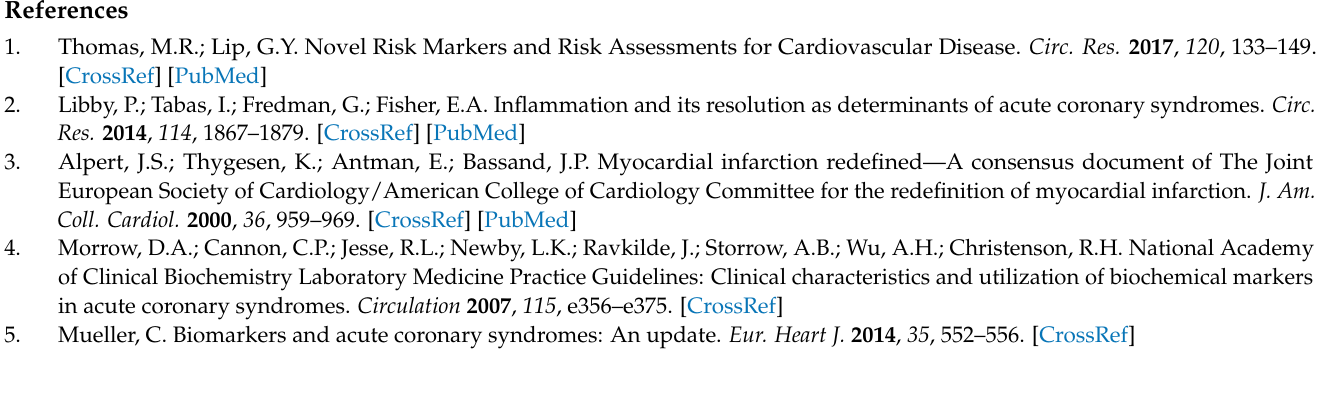
inflammatory cytokines; Figure S2: Serum levels of chemokines; Figure S3: Sub-analysis of let-7e- 5p expression by health status; Figure S4: Sub-analysis of regulation of let-7e-5p expression by pharmacological treatments; Figure S5: ROC curves of let-7e-5p measurements in the diagnosis of AMI vs. healthy controls and a sub-analysis of let-7e-5p expression performance by pharmacological treatments; Table S1: miRNAs differentially expressed during acute NSTEMI and at one-year follow- up; Table S2: Gene Ontology (GO) enrichment analysis of differentially expressed miRNAs in acute NSTEMI and at one-year follow-up; Table S3: Cytokine and chemokine signaling pathways were among the regulatory networks predicted by the miRSystem